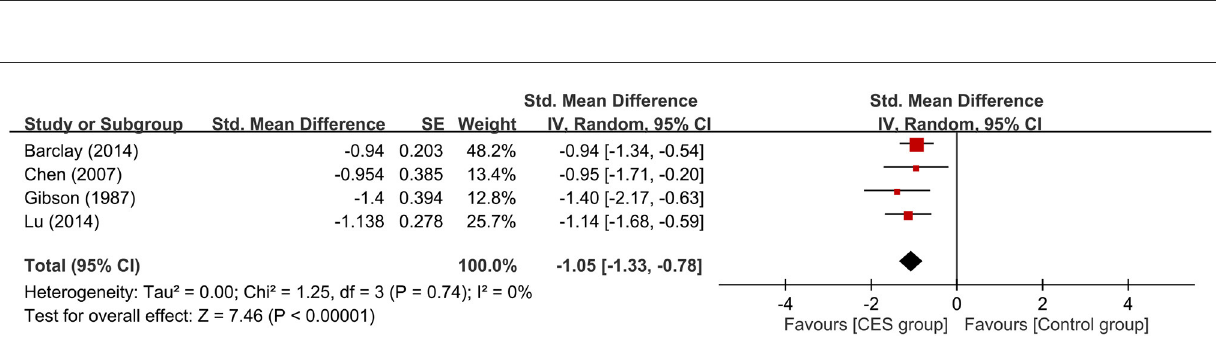
FIGURE4 Subgroup analysis of studies that used “Alpha-Stim” for cranial electrotherapy stimulation. CES, cranial electrotherapy stimulation; Std, standardized; CI, confidence interval; SE, standard error.